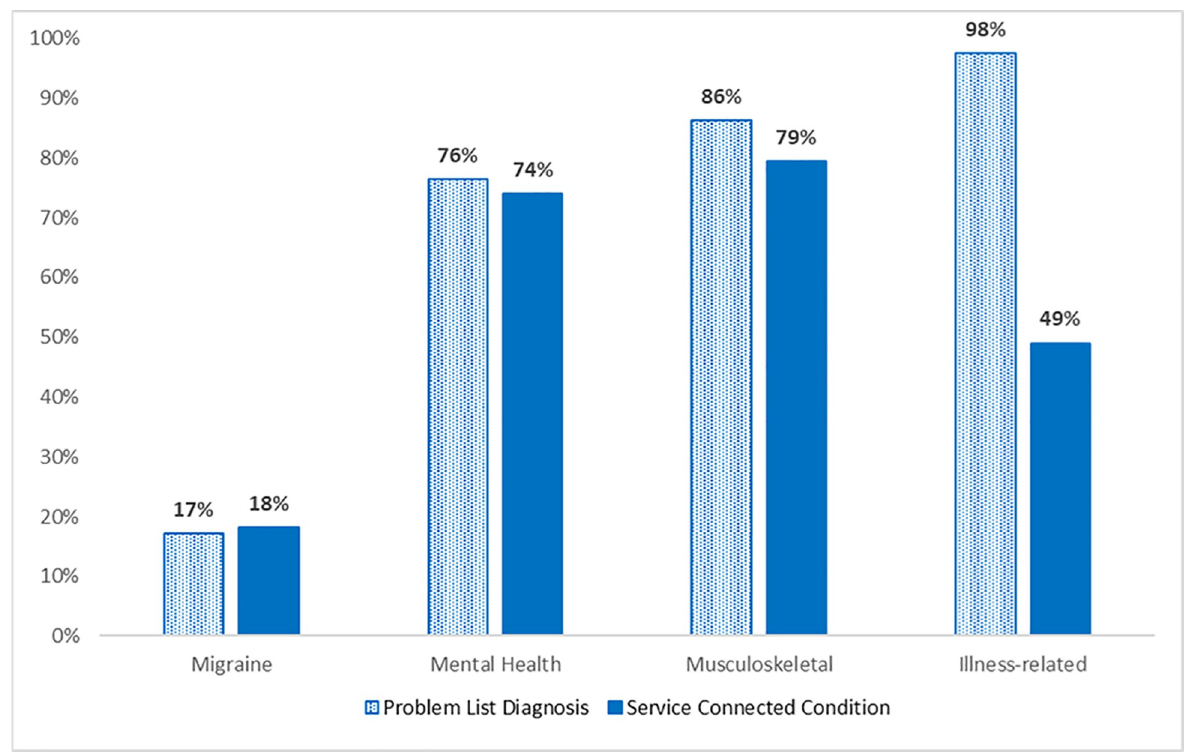
Fig 2. Problem list diagnoses and service-connection for migraine, mental health conditions, musculoskeletal/mechanical injuries, and illness related conditions.